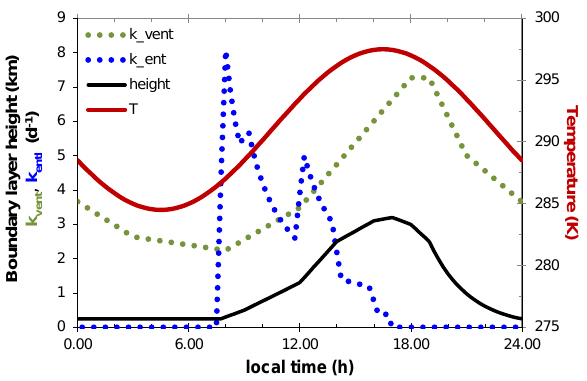
Fig. 1. Meteorological parameters prescribed in the box model Eu- lerian simulations. Solid lines show boundary layer height (km, black, left axis) and temperature (K, red, right axis). Dotted lines show k ent , the first-order rate of entrainment, i.e. vertical incorpora- tion of free tropospheric air due to increasing boundary layer depth (expressed in units of day − 1 , blue, left axis), and k vent , the first- order rate of ventilation, i.e. lateral exchange with background air due to advection and mechanical mixing (in units of day − 1 , green, left